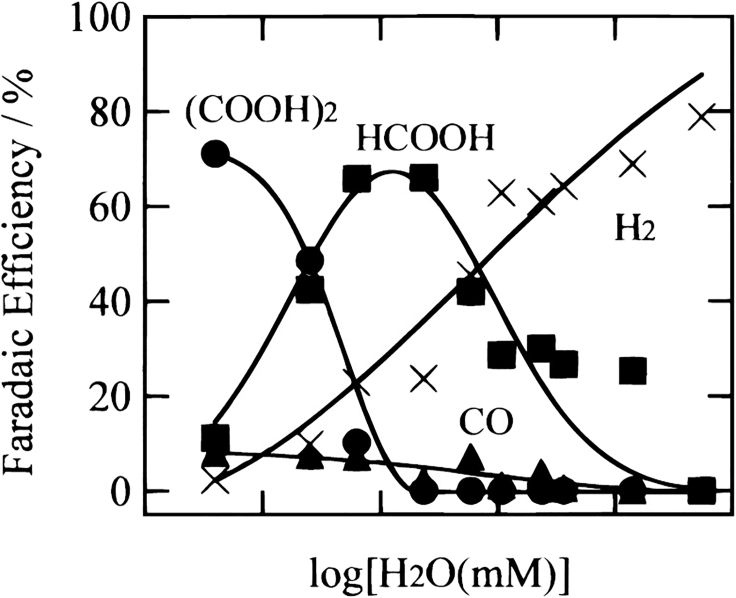
Faradaic Efficiencies for the Products (COOH)2, HCOOH, CO, and H2 at Different Water Contents in the Electrocatalytic Reduction of CO2 at Pt in AN at a Current Density of i = 5 mA·cm−2Reproduced with permission from (Tomita et al., 2000).